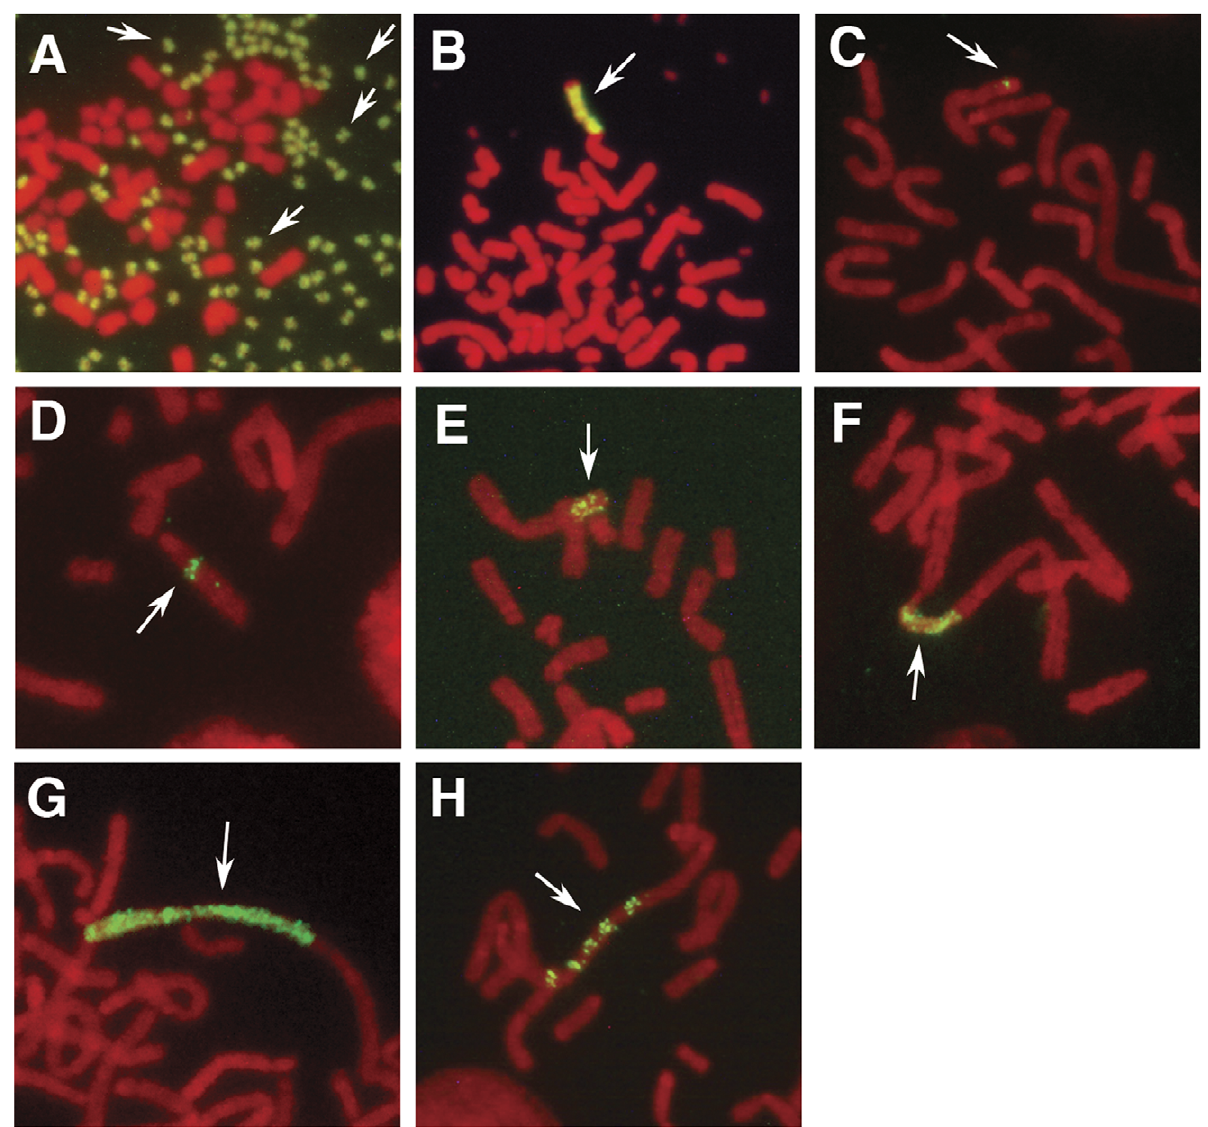
Figure 2. Generation of several kinds of amplified structures by the IR/MAR plasmid depending on the cell type. The IR/MAR plasmid was transfected into cells, a stable transformant was selected by drug selection, and a metaphase chromosome spread was prepared. Green fluorescence indicates the plasmid sequence after FISH and red fluorescence indicates the chromosome after propidium iodide (PI) staining. Representative images of several types of gene amplification are shown. In COLO 320DM cells, the plasmid was usually amplified as extrachromosomal DMs (A) or an chromosomal homogeneous array of HSR (B). In CHO DG44 cells (C to H), the IR/MAR plasmid was amplified as a chromosomal structure of varying length, including a tiny dot (C), a line (D) and a HSR longer than the metaphase chromosome width (cw), which appeared as either a fine ladder (E to G) or a ladder (H) structure. For the definition of these structures, see the text. The frequencies of these structures were counted and shown in the graphs appearing in Figures 3 to 5 using the legend shown in panel I of this